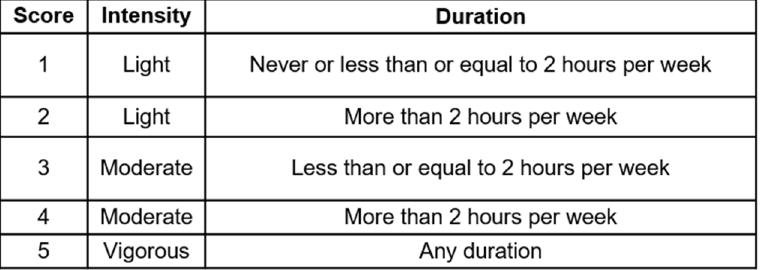
Figure 1. Physical activity score. Scores were calculated based on the highest intensity and duration of physical activity engaged by patient per week.